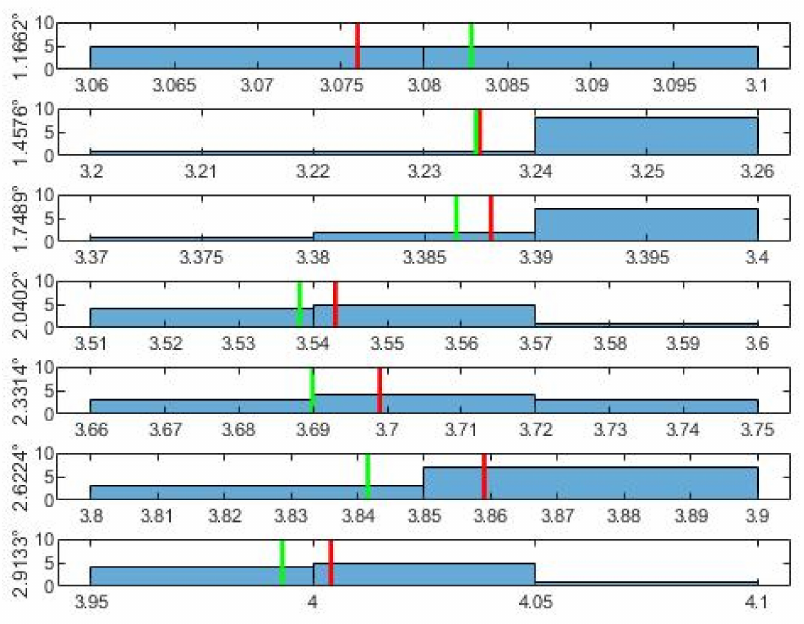
Figure 7. Histograms of the third 7 measurements. On the left there is the appropriate angle and multitude. The red line is the mean u ; th green line is the LSM value of u appropriate to